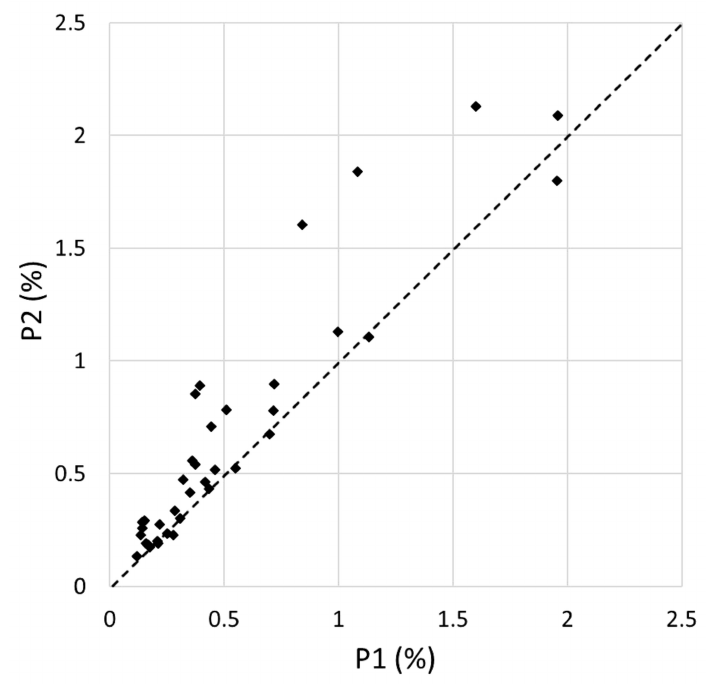
Figure 3. Mean cover (in %) of the most common understory plant species (in herb and shrub layer) in two monitoring periods; P1: years 2004 / 2005, P2: years 2014 / 2015. Dots indicate 38 plant species that were present at least in 25% of all plots (see Table 4).